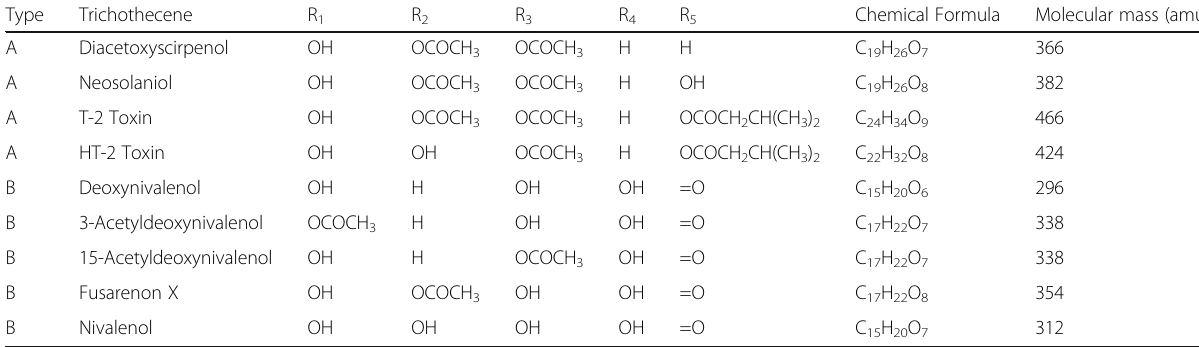
Table 2 Representation of different groups contained in trichothecenes structures